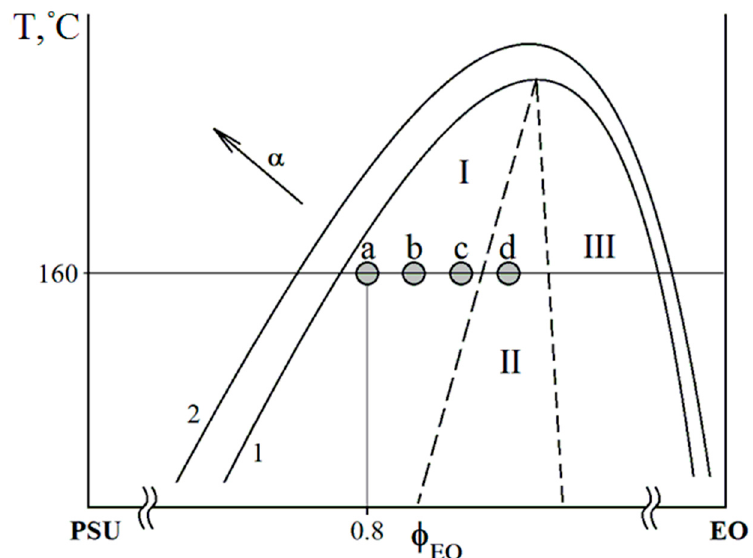
Figure 9. Schematic representation of PD in progress curing, where: 1—PD model systems PSU–EO; 2—model PD PSU–EO + FGE. o–figurative points of the curable systems PSU/FGE (wt. %): a—20/0, b—20/10, c—20/20, d—15/0. I, III—PD regions, where a “matrix-dispersion”; II—PD region, where a structure of the “interpenetrating phases” type is formed.